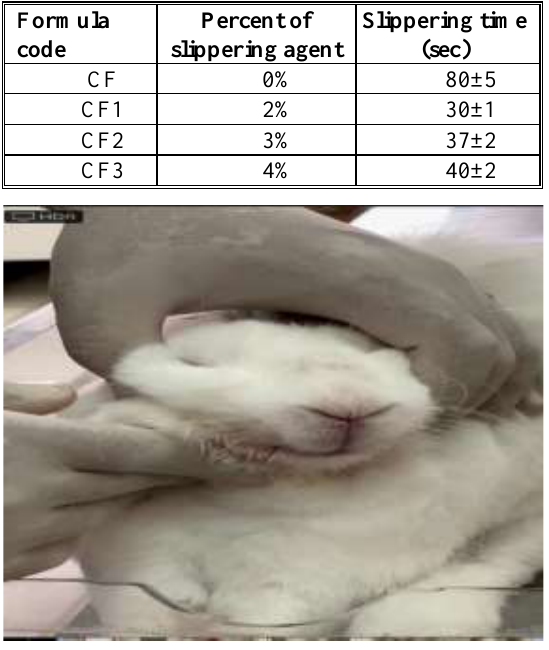
Figure 4. Performing slippering test in albino Rabbit Dissolution of IRB and